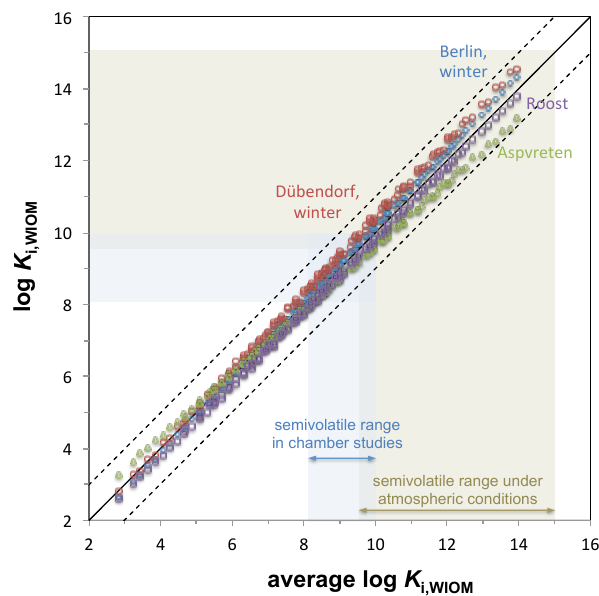
Figure 5. Plot comparing the partition coefficients at 25 ◦ C of alka- nes and their oxidation products between the water-insoluble or- ganic matter of aerosol and the gas phase ( K i, WIOM ) predicted with four ppLFERs calibrated with empirical data for different ambient aerosol samples (Arp et al., 2008b). The blue and beige shading indicates where gas–particle partitioning of organic compounds is sensitive to the values of K i, WIOM under conditions prevailing in chamber studies and the atmospheric environment, respectively (Lei and Wania,